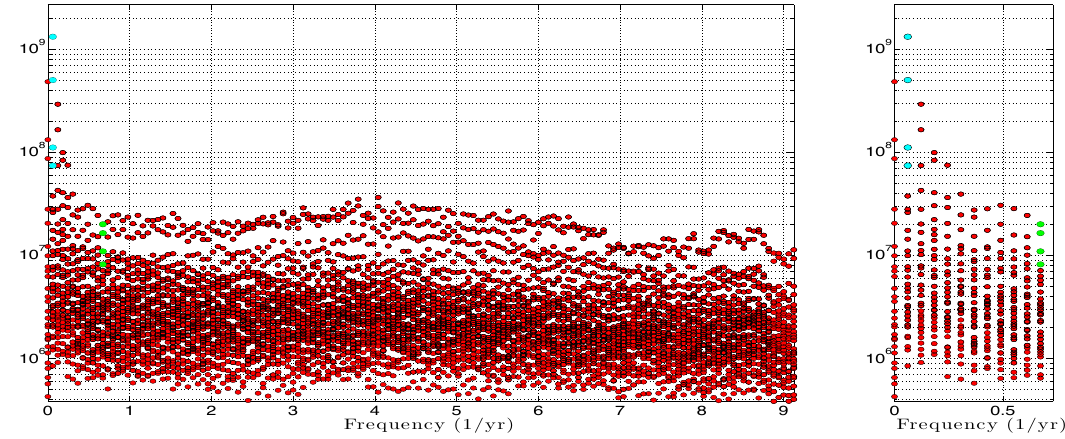
Figure 2. DAH power spectrum P (cid:96) of 30 leading PCs of the upper layer stream function anomalies. Left panel: Each discrete set P (cid:96) consists of 30 eigenelements (equal to number of input dataset’s channels), corresponding to the pairs of DAH eigenvalues | λ j | and eigenvectors W j at a given temporal frequency f (cid:96) (see Section 4.2.1 and (15)–(17)). Figures 3 and 4 show DAHMs associated with four largest | λ j | at two selected frequencies: cyan, decadal LFV peak f D = 0.061 y − 1 ( ≈ 17 y ); green, interannual f I = 0.674 y − 1 ( ≈ 1.5 y ). The right panel shows a magnification of the low-frequency part of the